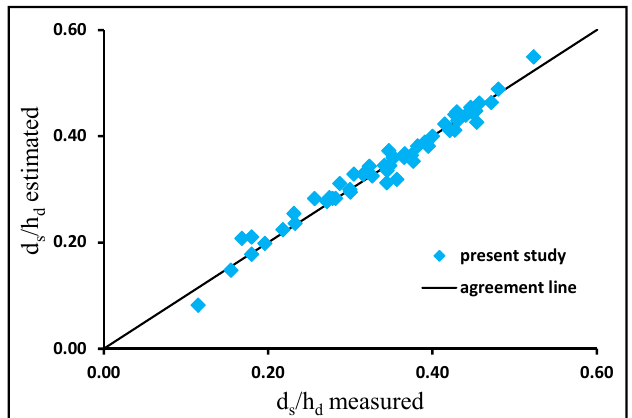
Figure 14. Comparison between measured and estimated d sm /h in present study.